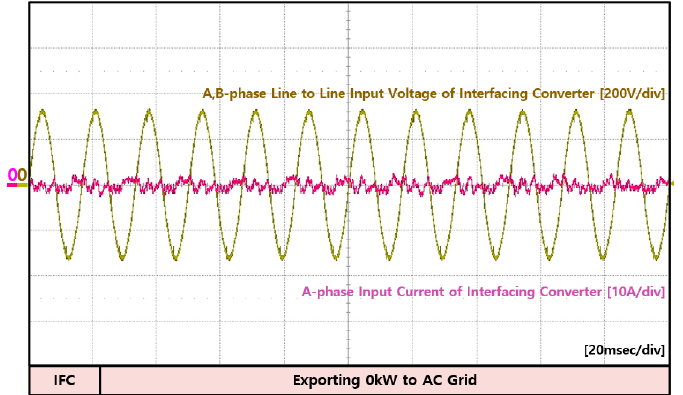
Figure 23. Experiment waveforms of interfacing converter at AC grid in mode 4.